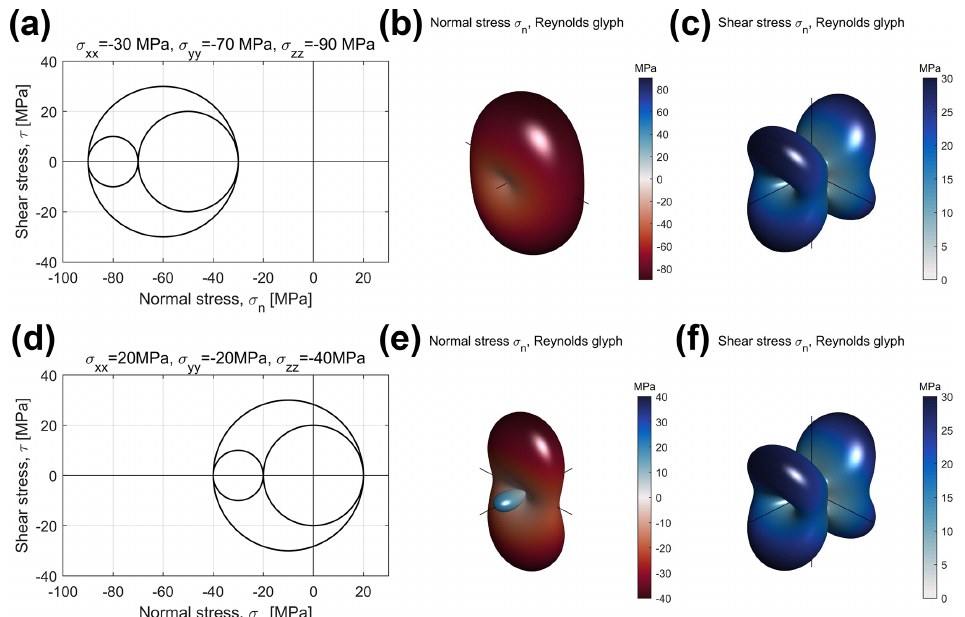
Figure 9. Examples of stress tensors depicted in Mohr space ( σ n , τ ) and as Reynolds (normal stress, σ n ) and HWY (shear stress, τ ) glyphs. (a–c) Triaxial compression (taken as negative, red colour). (d–f) General triaxial stress with one principal stress tensile ( σ xx